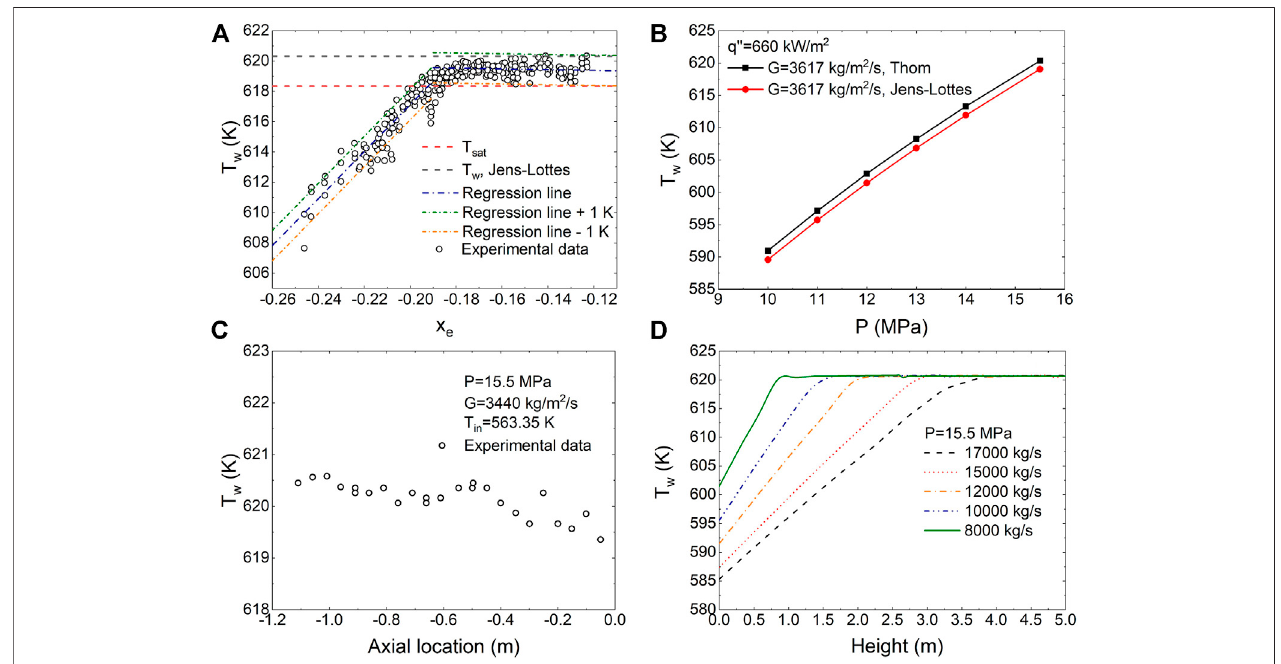
FIGURE 9 | (A) Experimental data of wall temperature in subcooled boiling regime from the study by Cubizolles et al. (2009); the experimental data are compared againstJens – Lottescorrelation.Thistestissubsequenttotheboilingtestshownin (C) . (B) comparisonofwalltemperaturepredictedusingJens – Lottescorrelationand Thom correlation under the normal PWR-type condition in this work. The temperature is compared at 10 7 s. (C) Experimental data of wall temperature in saturated boiling regime in the study by Cubizolles et al. (2009). (D) Simulation results of wall temperature under several PWR-type conditions in this work. In our model, the area of the entire core was estimated as 4.7 m 2 . Therefore, 17,000, 15,000, 12,000, 10,000, and 8,000 kg/s correspond, respectively, to 3,617, 3,191, 2,553, 2,128, and 1,702 kg/m 2 /s.